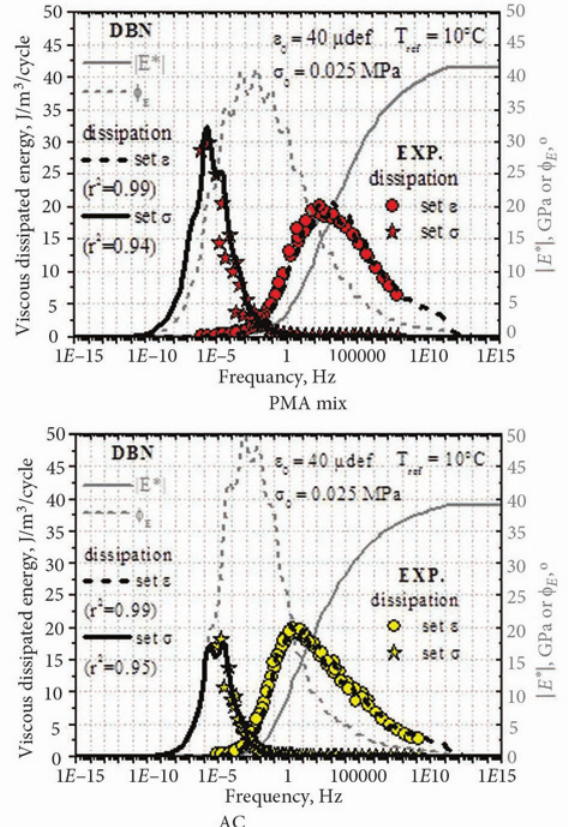
fig. 4. Master curves of complex modulus norm | E *| and phase angle ϕ E and viscous dissipated energy for set σ and set ε